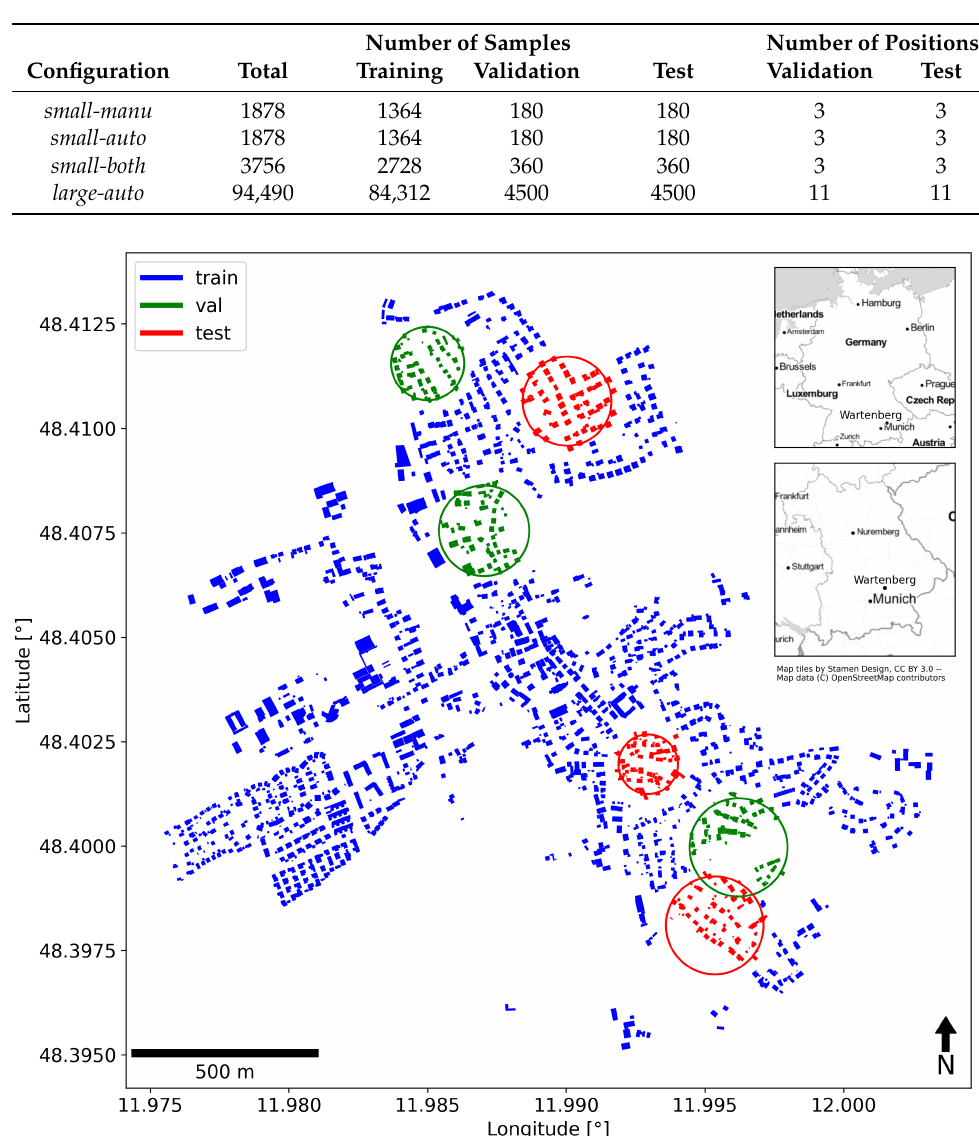
Figure 3. Data split of the small-scale datasets small-manu and small-auto (identical number, location, and size of training samples) with areas containing training (train), validation (val), and test data. The datasets are based on the German village of Wartenberg. Its location within Bavaria and Germany, respectively, is indicated in the overview